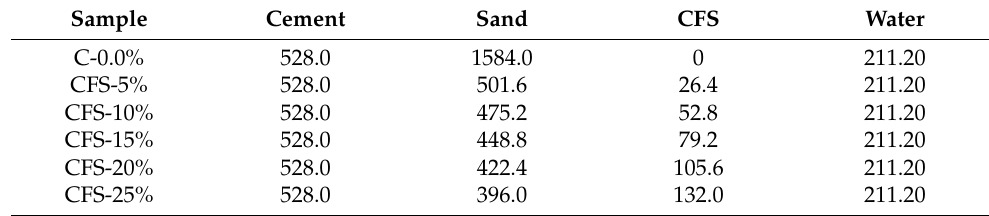
Figure 5. The view of ( A ) scanning electron microscopy (SEM) device; ( B ) specimens. 6. Test Results and Discussions The physical and mechanical properties of the CFS mortar were examined. The re- sults of the experiment are summarized in Table 4, which includes consistency, unit weight, water absorption, compressive strengths at 7 and 28 days, flexural strength, and microstructural analyses.